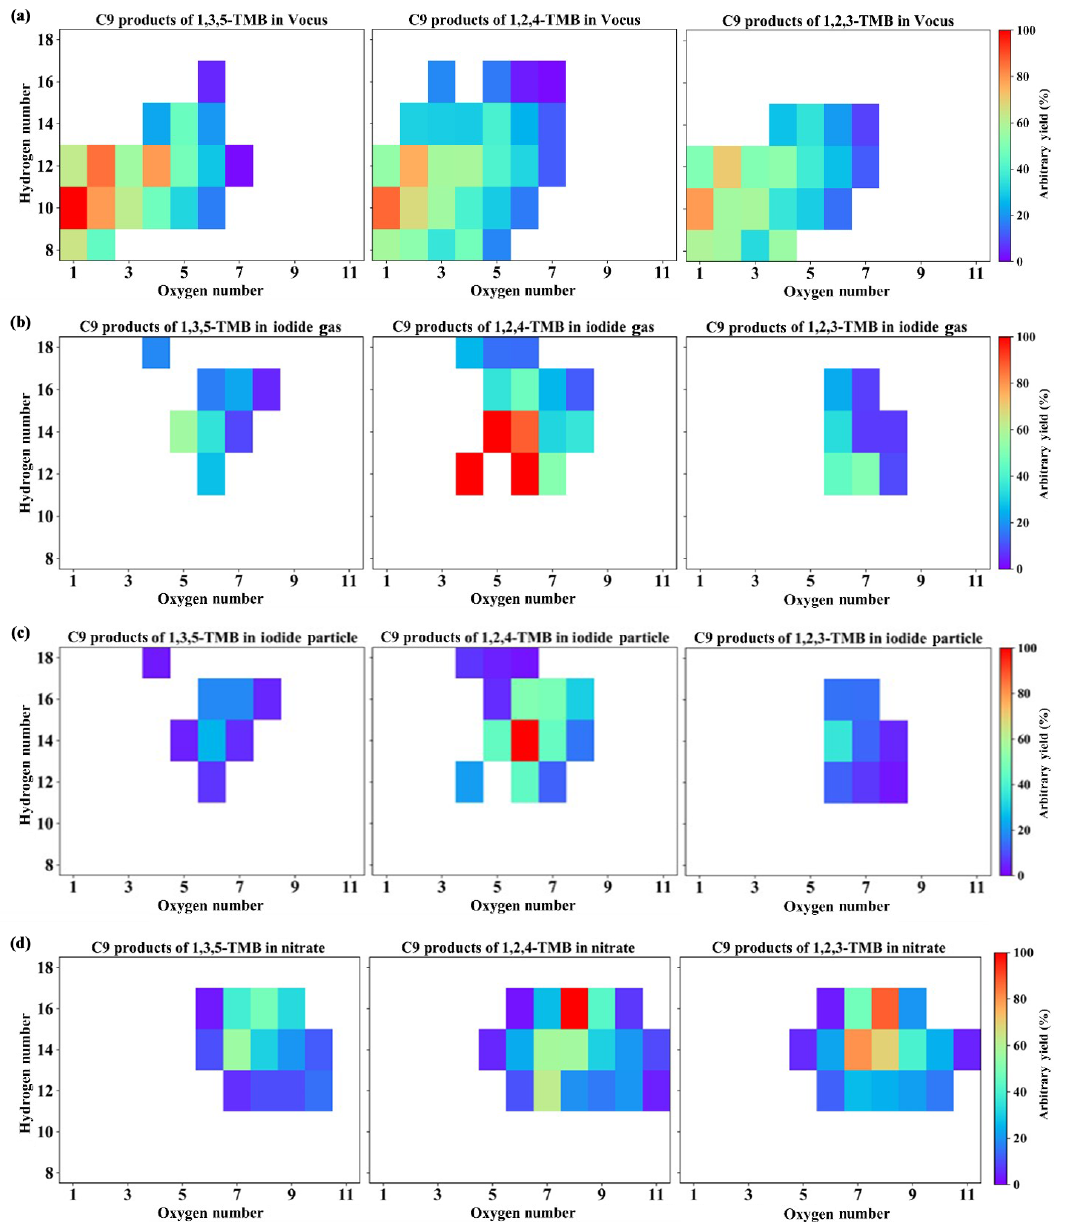
Figure 3. Distribution of C 9 products formed from OH-initiated reactions of TMBs (Exp. 1–3 in Table 1) by (a) the Vocus PTR, (b) the iodide CI-TOF for the gas phase, (c) the iodide CI-TOF for the particle phase, and (d) the nitrate CI-APi-TOF. The yield of the most abundant product for each instrument is arbitrarily set to be 100%, but note that the arbitrary yields are not comparable among instruments. Also note that the signal of the Vocus PTR was processed in a logarithmic way before calculating the arbitrary